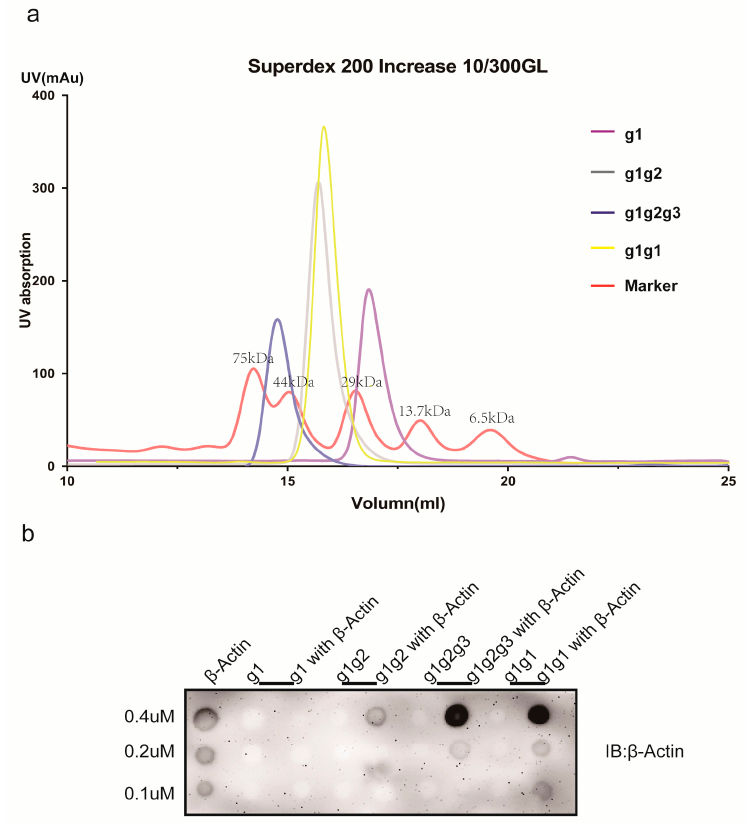
Figure 4. The aggregation of the protein in solution and binding to β -actin. ( a ) The chromatogram from a size-exclusion column showing the aggregation state of the protein. The red line indicates the molecular weight marker. The molecular weights from left to right are 75, 43, 29, 13.7 and 6.5 (kDa), respectively. ( b ) Dot blots of the interactions of g1, g1g2, g1g2g3, and g1g1 with β -actin. β -actin was derived from the total cell lysate of H1299 cells. The secondary antibody was a mouse anti-antibody.